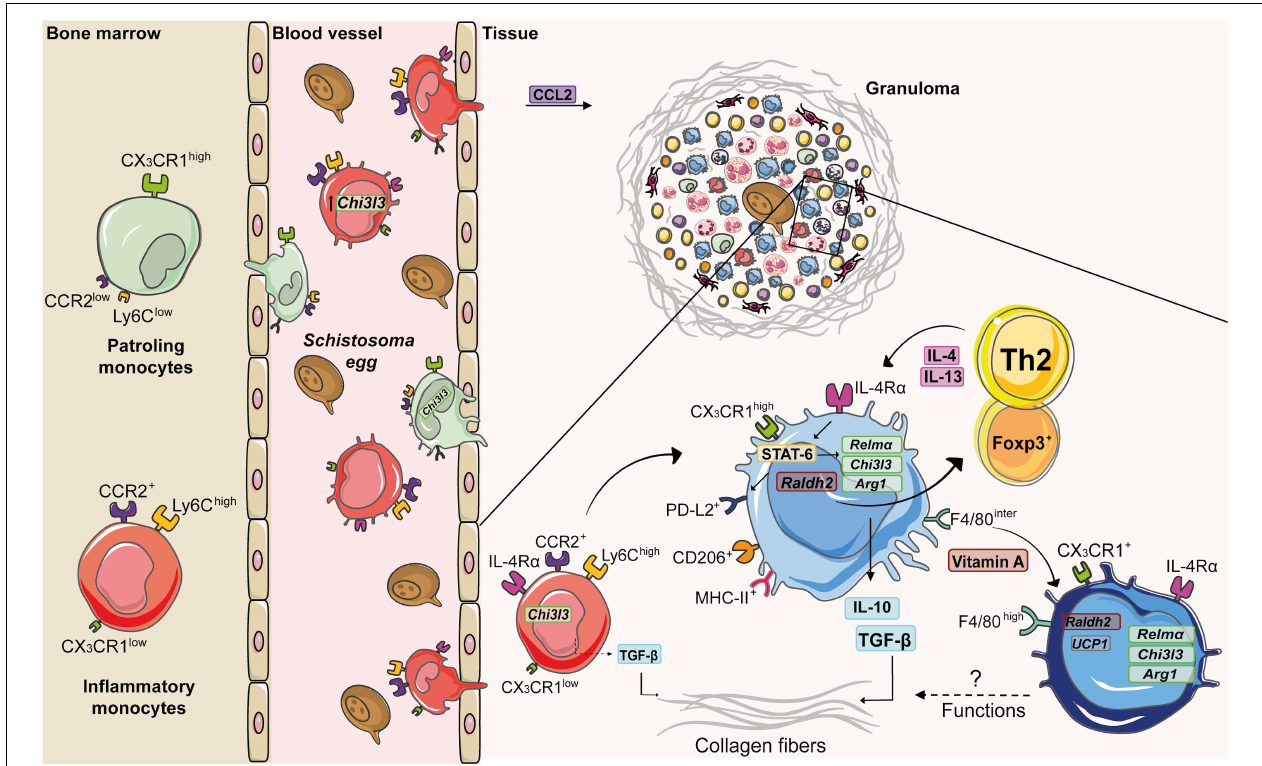
FIGURE 2 | Monocyte and macrophage dynamics during experimental S. mansoni infection. Along the course of experimental S. mansoni infection in mice, bone marrow increases the monopoiesis and originates two subsets: inflammatory monocytes (Ly6C high CCR2 high CX 3 CR1 low ) and patrolling monocytes (Ly6C low CCR2 low CX 3 CR1 high ), which are recruited from blood to tissues affected by egg accumulation. Upon activation by circulating eggs, inflammatory monocytes express higher levels of chitinase-like 3 ( Chi3l3 ) compared to patrolling monocytes. CCL2 mediates inflammatory monocyte recruitment to the liver during schistosomiasis. Inside the tissue, inflammatory monocytes produce TGF- β , induce collagen deposition and differentiate into macrophages. The diversity of cells present in the granuloma is responsible for a type 2 microenvironment, whereby T cells produce IL-4 and IL-13 that induces the alternative activation of macrophages via IL-4R α . The IL-4/IL-13/IL-4R α axis leads to the transcription of retinaldehyde dehydrogenase 2 ( Raldh2) and activation of signal transducer and activator of transcription 6 (STAT-6). This transcription factor upregulates the expression of Chi3l3 , programmed cell death ligand 2 ( Pdl2) , arginase -1 ( Arg1) and resistin-like alpha (Relma), which trigger TGF- β production and collagen deposition. RALDH2 by AAM induces Treg cell differentiation. Vitamin A mediates conversion of monocyte-derived macrophages (F4/80 int CD206 + PD-L2 + MHC-II + ) into F4/80 high CD206 - PD-L2 - MHC-II - UCP1 + phenotype, whose function still needs to be